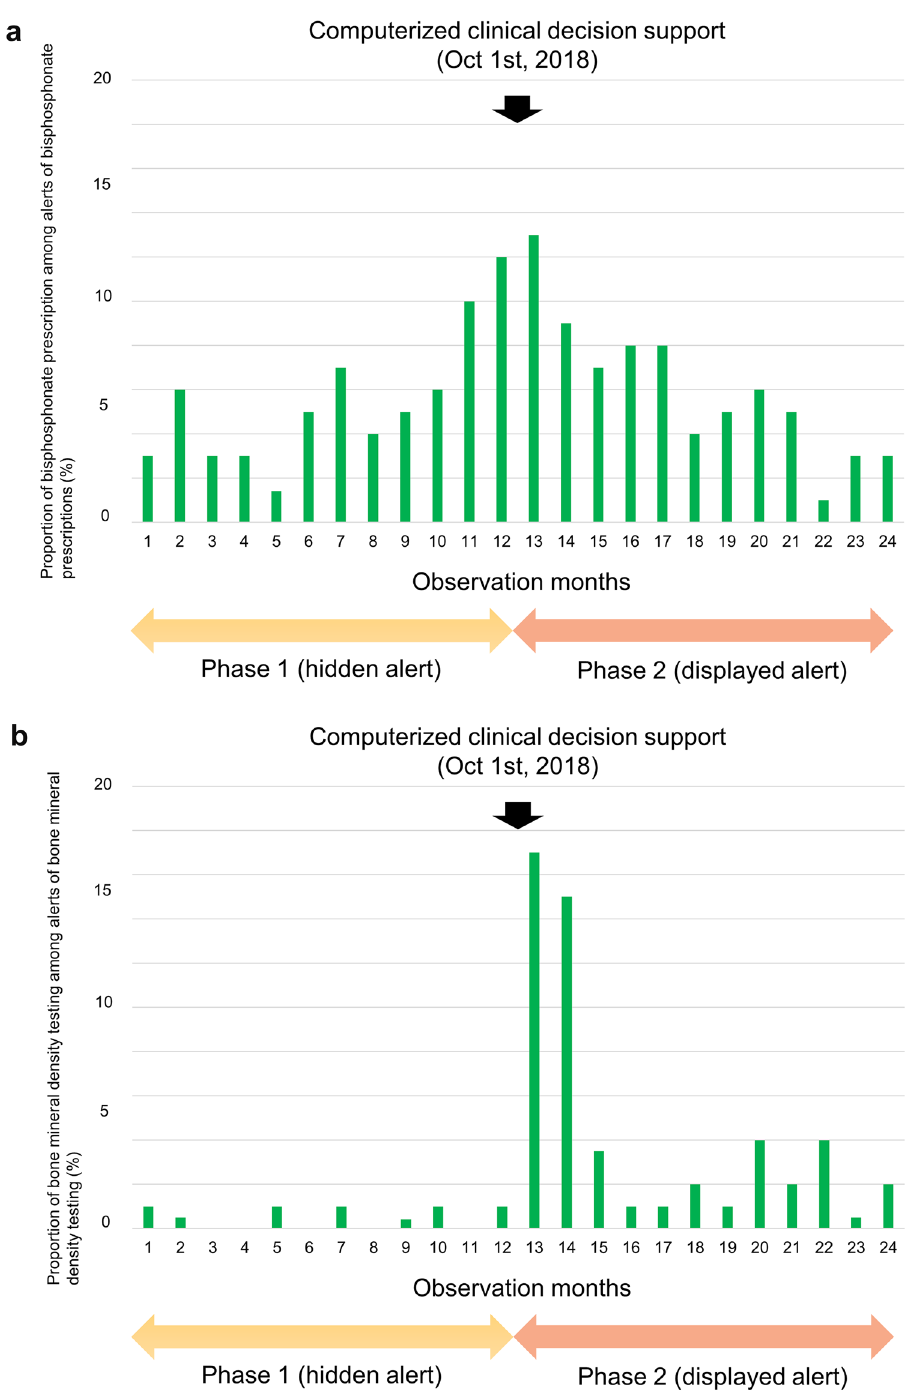
Figure 2. Time trend of prevention of glucocorticoid-induced osteoporosis. ( a ) Bisphosphonate prescription. ( b ) Bone mineral density